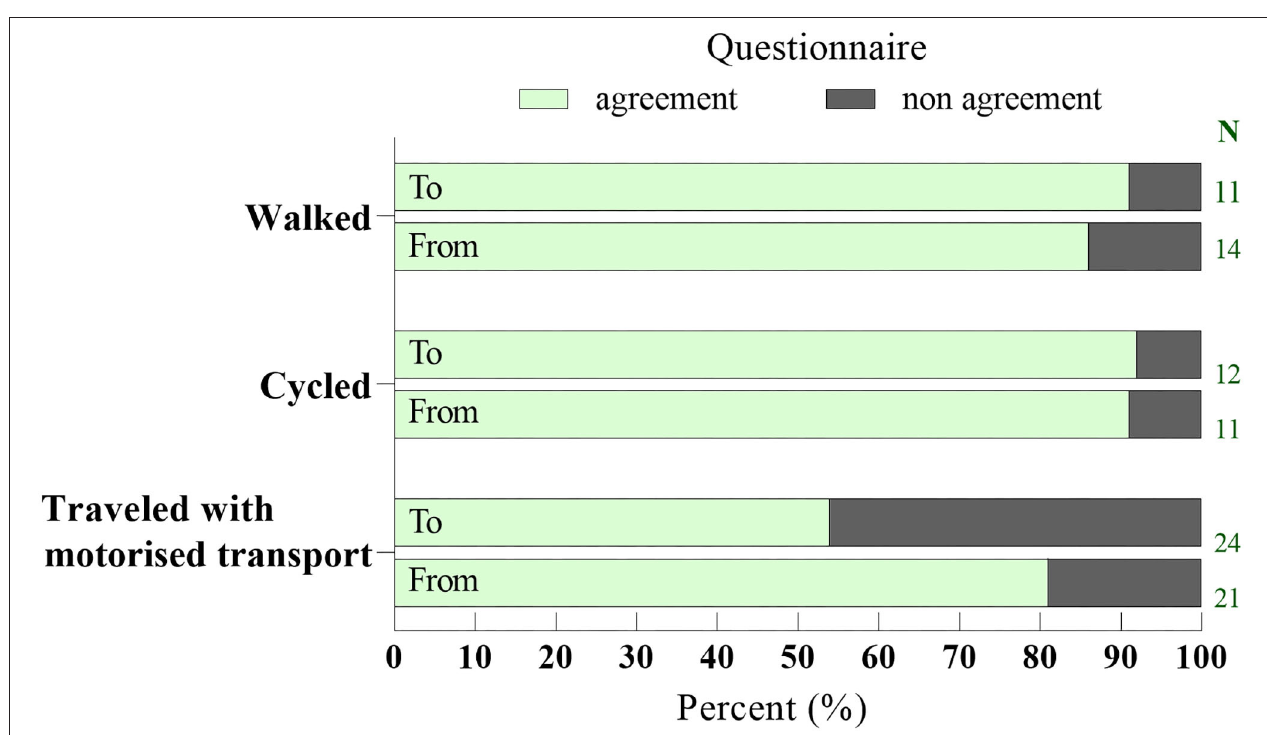
FIGURE 2 | Percentage of reported transport modes to ( n = 47) and from ( n = 46) school in the questionnaire, stratified by transport mode from travel diaries.